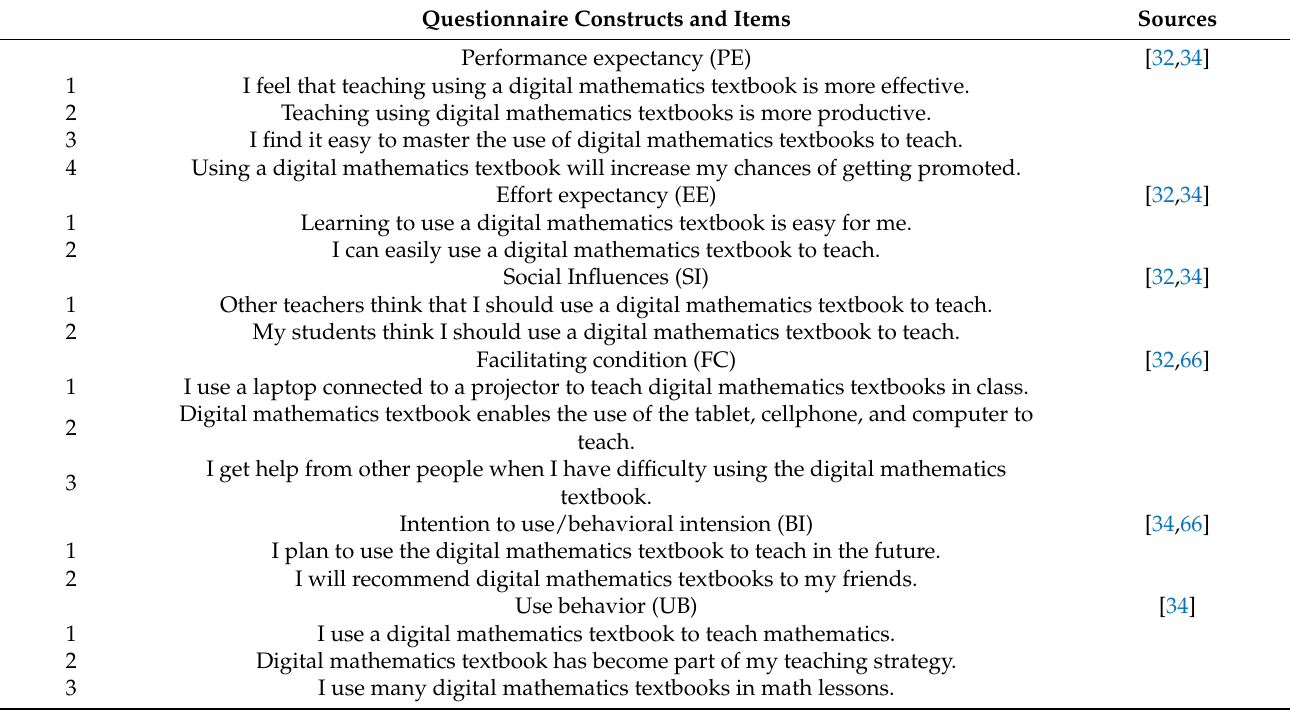
Table 2. UTAUT questionnaire to assess teachers’ intention and usage of mathematics digital